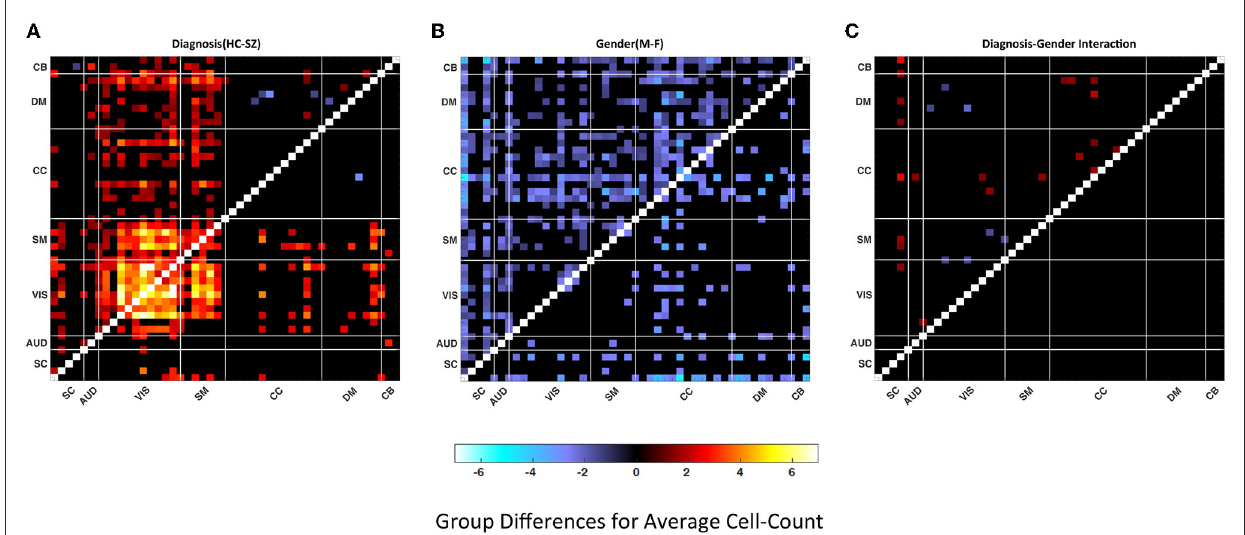
FIGURE7 Group differences in (A) Healthy control—patient, (B) Male–female, (C) Diagnosis-gender interactions for average cell-count. Values are plotted for thresholded p -values*–log 1 0( p -value) sign (t-statistic) where p -values masked for significance at p ≤ 0.05 in the upper triangular matrices and thresholded FDR corrected p -values* –log 1 0 ( p -value) sign (t-statistic) where FDR corrected p -values are masked for significance via Benjamini–Hochberg procedure in the lower triangular matrices. Statistics are obtained via linear regression analysis (red shades represent the dominance of HC or F and the blue shades represent the dominance of SZ or